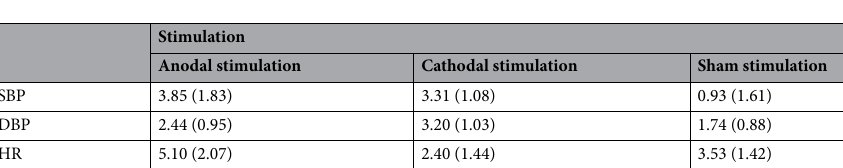
Table 2. Means and standard errors (in parentheses) of systolic blood pressure, diastolic blood pressure and heart rate reactivity scores during the five minutes of task performance. Reactivity scores are calculated